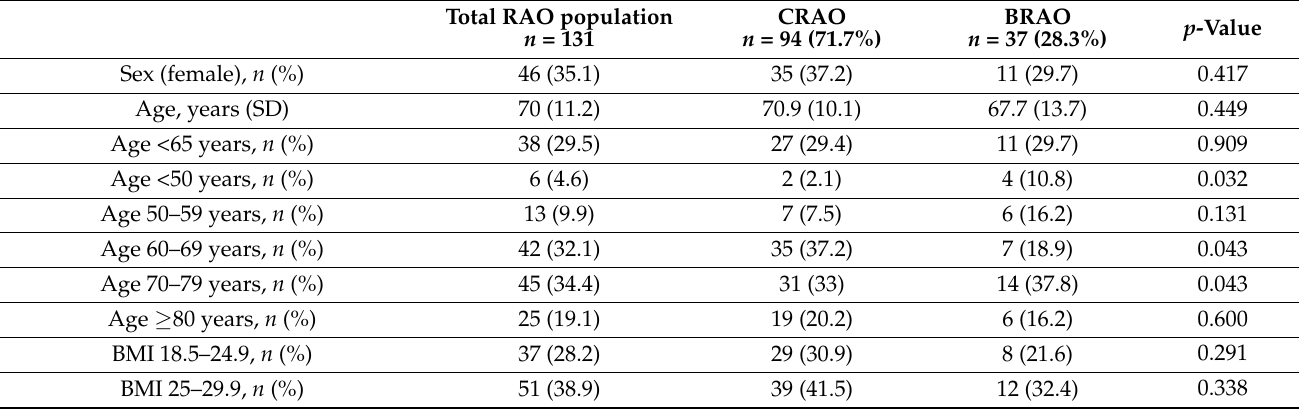
Table 1. Characteristics of the study